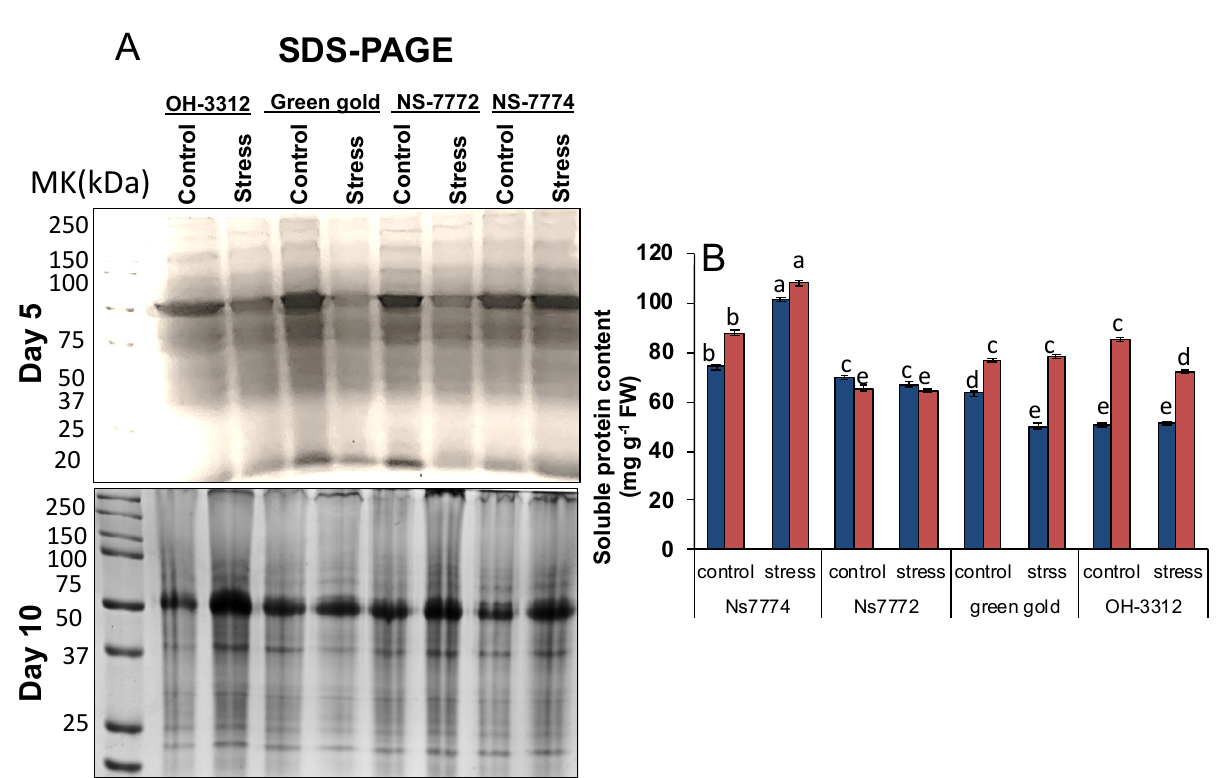
Figure 11. Changes in protein profile ( A ) SDS-PAGE and ( B ) soluble protein content, as affected by drought stress at 5 and 10 days of interval in okra genotypes NS7774, NS7772, Green Gold, and OH3312, along with respective controls. Afterwards, proteins extracted from leaves were run on 12% polyacrylamide gel electrophoresis and stained with Coomassie Brilliant Blue R-250. (Vertical bars indicate mean ± SE for n = 5. Means denoted by the different letter are significantly different at p ≤ 0.05 according to the Tukey’s studentized range test.